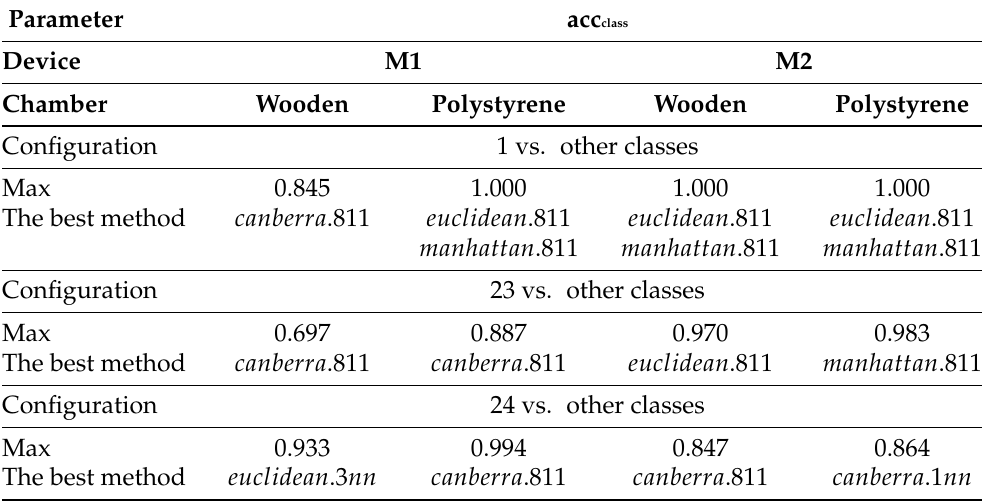
Table 4. Summary of the highest acc class values obtained in the 5 × MCCV-5 validation tests: specific class vs. other classes including the classifiers that enabled obtaining them: devices M1 and